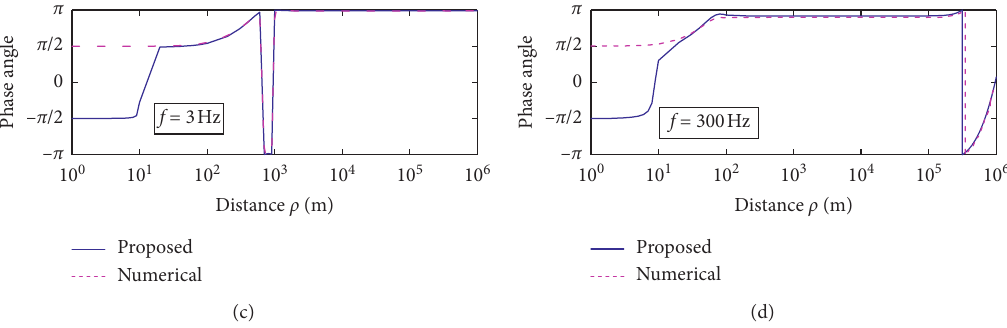
Figure 3: Amplitudes and phase angles of the field component E solutions. (a, c) f � 3Hz. (b, d) f � 300Hz.